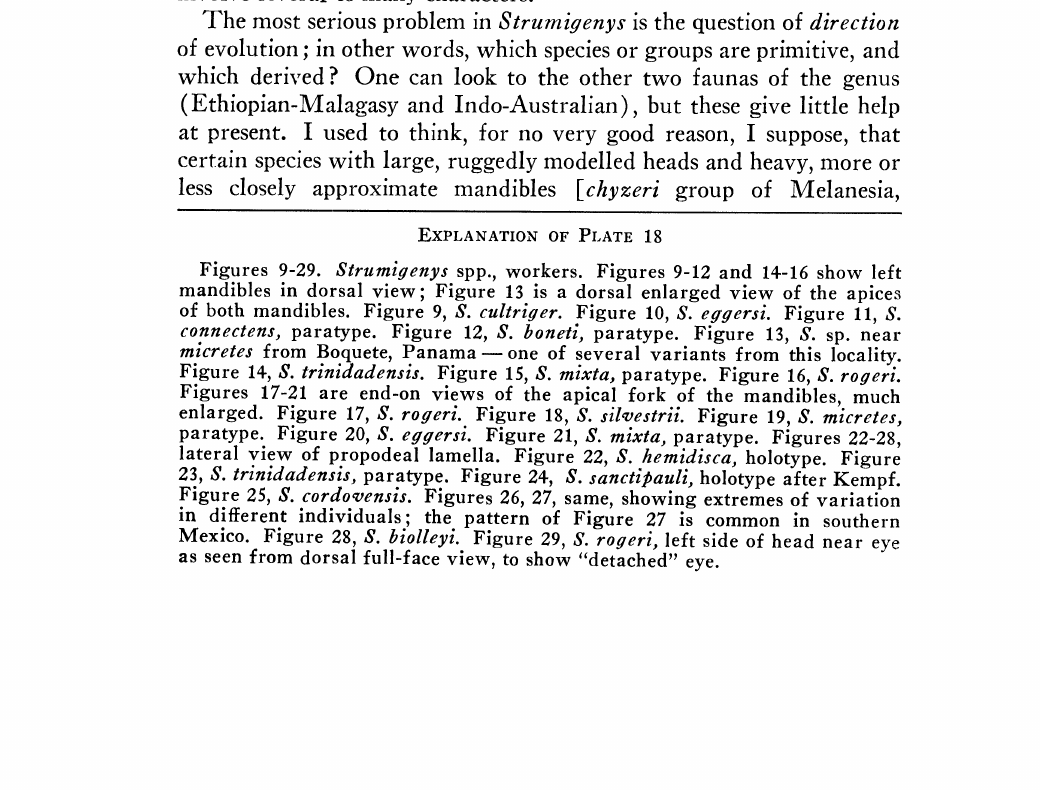
23, ’. trinidadensis, paratype. Figure 24, ’. sanctipauli, holotype after Kempf. Figure 25, g. cordoeensis. Figures 26, 27, same, showing extremes of variation in different individuals; the pattern of Figure 27 is eommon in southern Mexico. Figure 28, ’. biolleyi. Figure 29, S. roeri, left side of head near eye as seen from dorsal full-faee view, to show "detaehed"